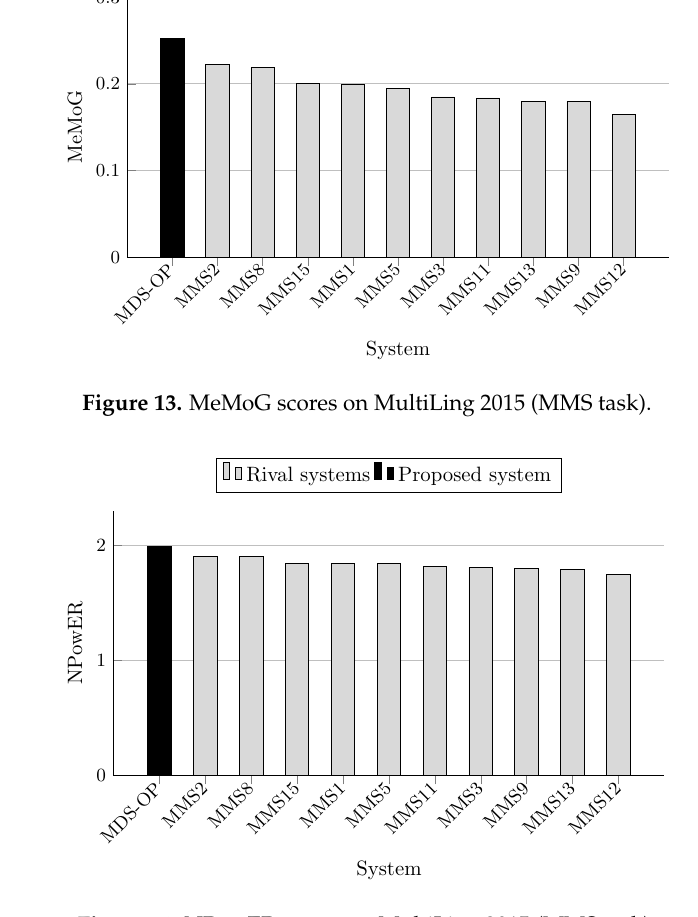
Figure 14. NPowER scores on MultiLing 2015 (MMS